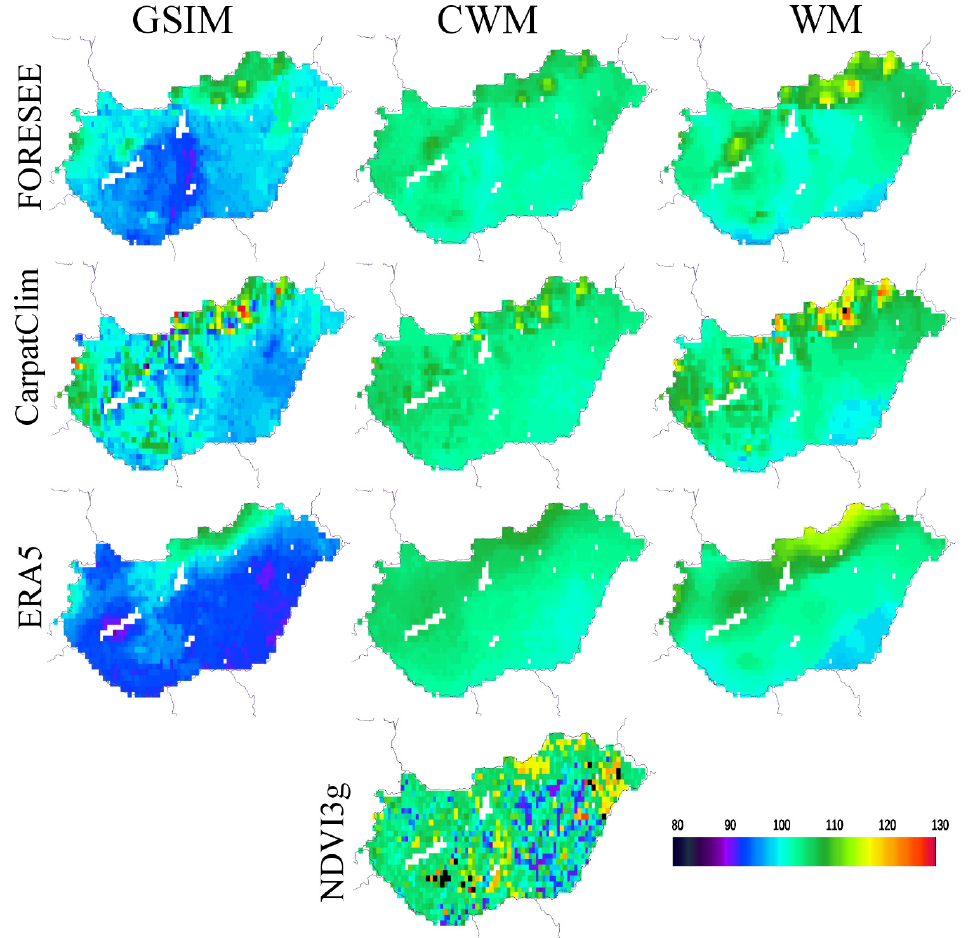
Figure 2. Start of season (SOS) climatology maps (expressed as day-of-year) showing mean values for the 1982–2010 period. Day-of-year values were calculated by combining three phenology models (vertical) and three meteorological datasets (horizontal). The observation-based NDVI3g SOS dataset is provided as a reference. Pixels excluded from the analysis due to low vegetation cover are in white.